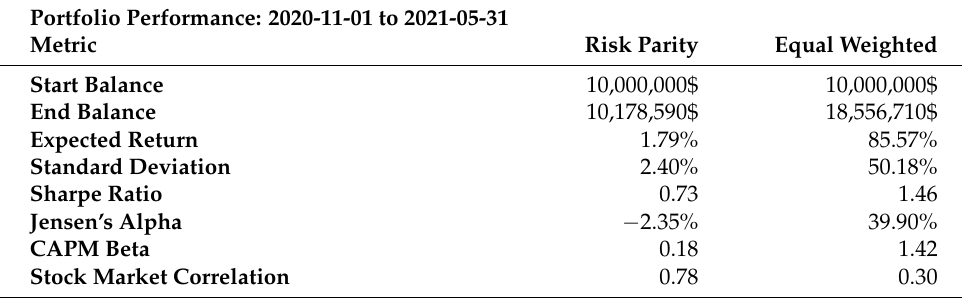
Table 6. Risk parity versus equal weighting during COVID-19 Phase II.